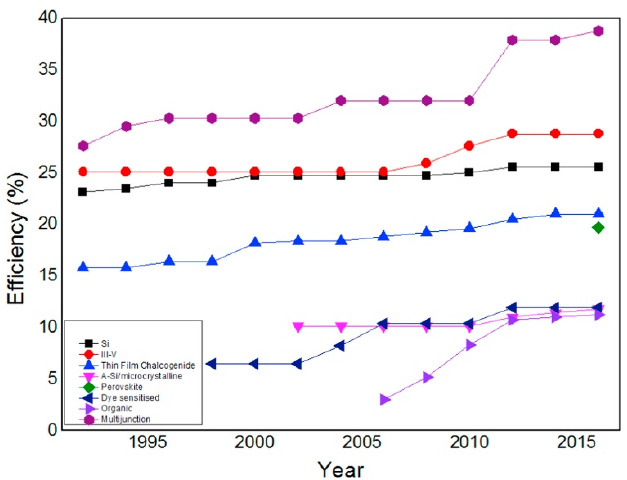
Figure 7. Solar cells’ efficiency reported based on several technologies (reproduced from [224] with permission from the Elsevier).